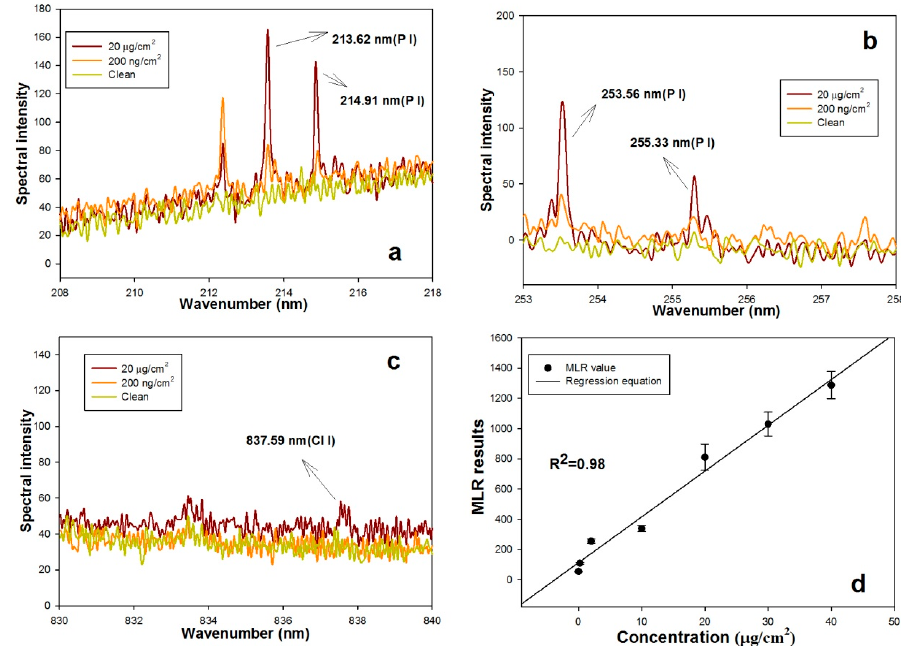
Figure 4. The laser-induced plasma spectral characteristics of chlorpyrifos in a leaf. ( a ) The spectral characteristics of the element P at 213.62 nm and 214.91 nm; ( b ) The spectral characteristics of the element P at 253.56 nm and 255.33 nm; ( c ) The spectral characteristics of the element Cl at 827.59 nm; ( d ) The multi-variable linear regression model for chlorpyrifos measurement based on the spectral characteristics of P and Cl.